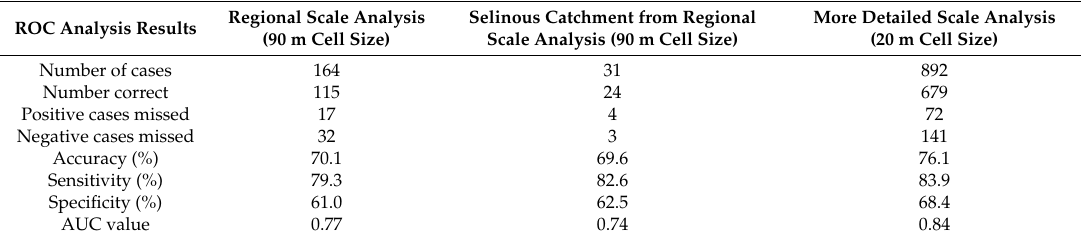
Figure 5. Receiver operating characteristics (ROC) curves of the LR model for the regional scale analysis (referring to both the entire system of catchments and Selinous catchment) and the more detailed scale analysis. Table 5. ROC analysis results of the LR model for the regional scale analysis (referring both the entire system of catchments and Selinous catchment) and the more detailed scale analysis.